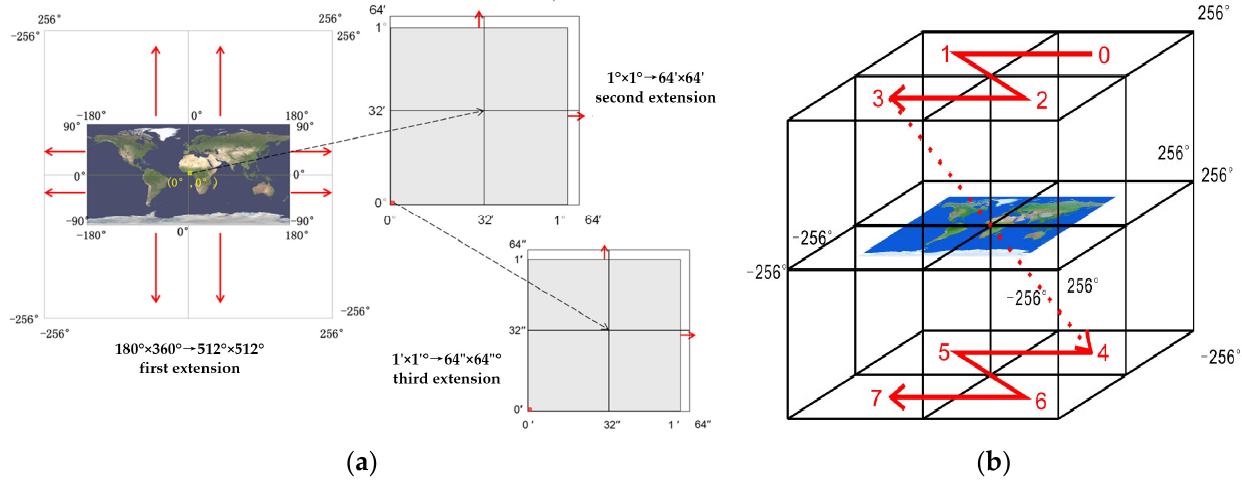
Figure 1. Earth meshing framework. ( a ) GeoSOT meshing framework [40]; ( b ) GeoSOT-3D meshing